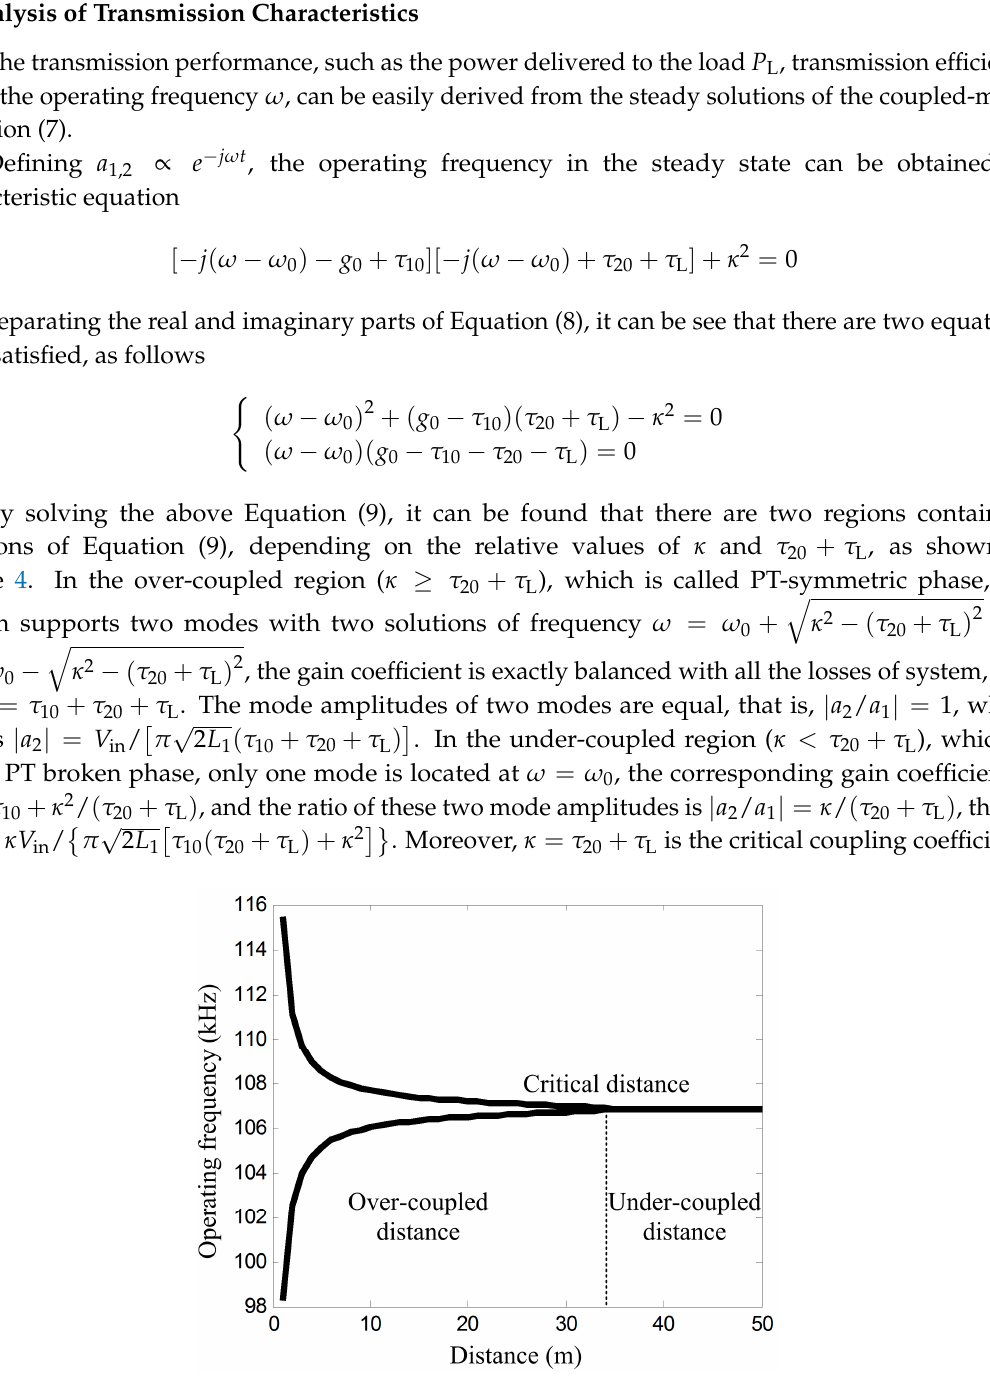
Figure 4. Theoretical values of the operating frequency. The critical distance is about 34 m, which is far greater than the transmission distance of the typical WPT system.